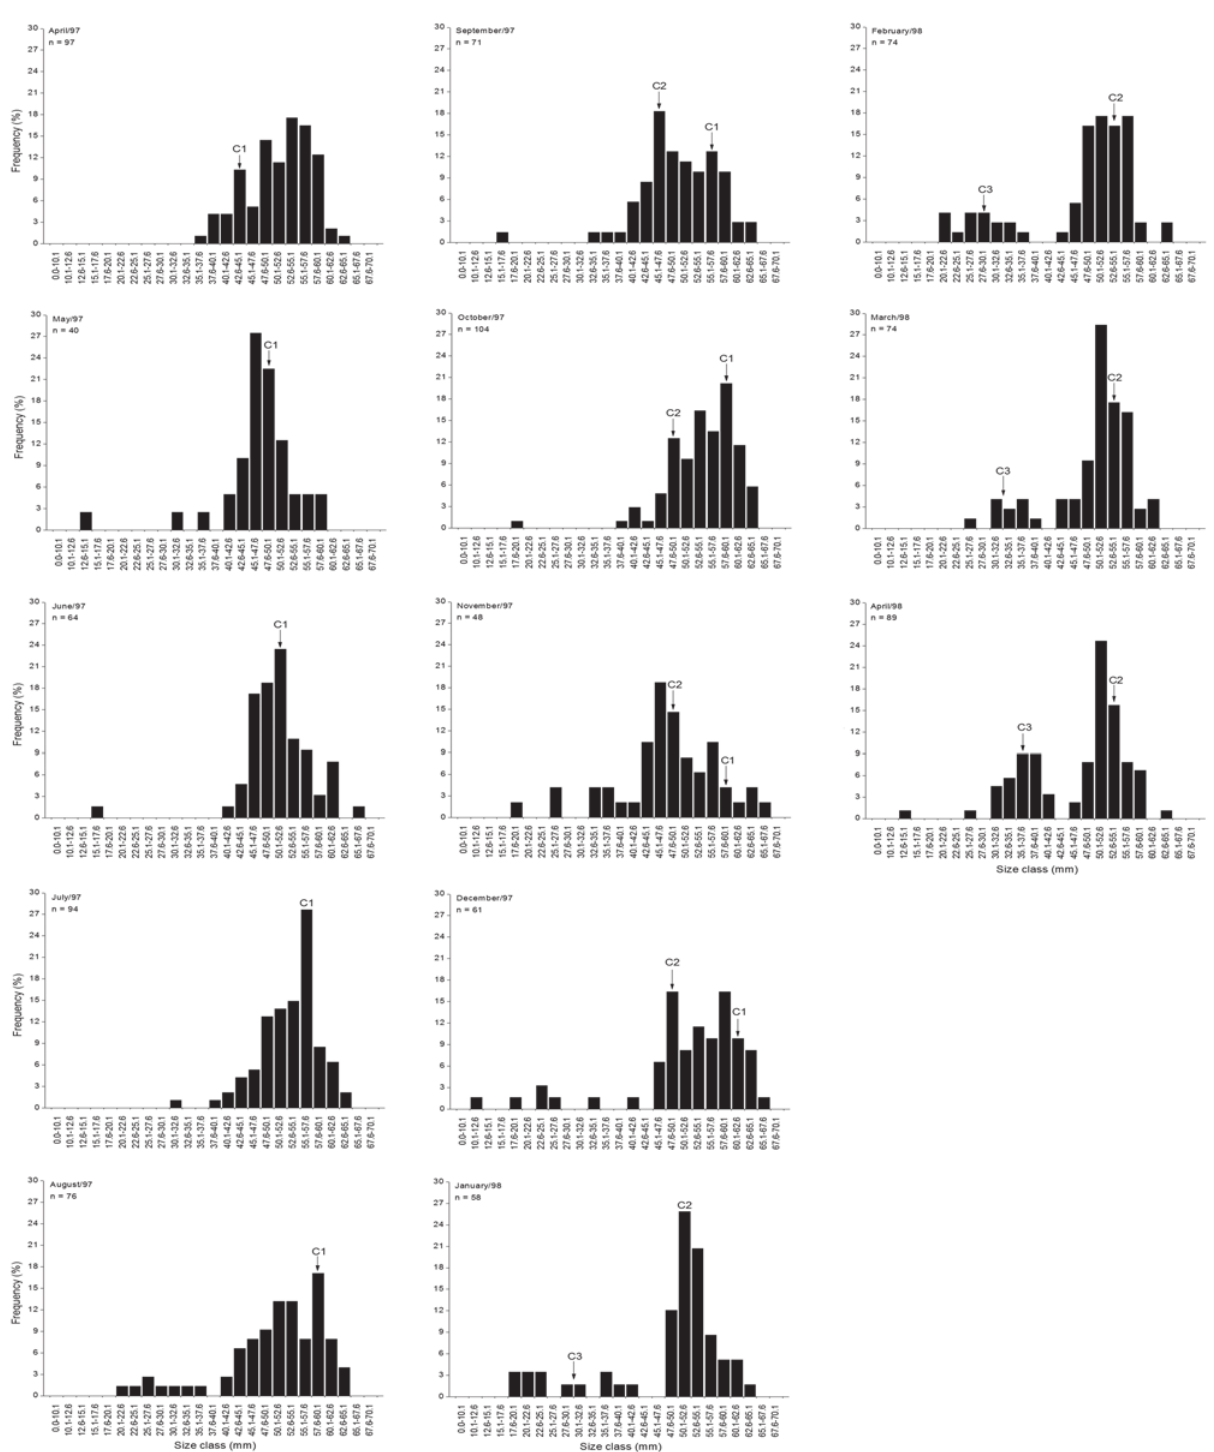
Figure 3. Tagelus plebeius . Frequency distribution of size class shell in the sites grouped in the differences months of study in the Enseada